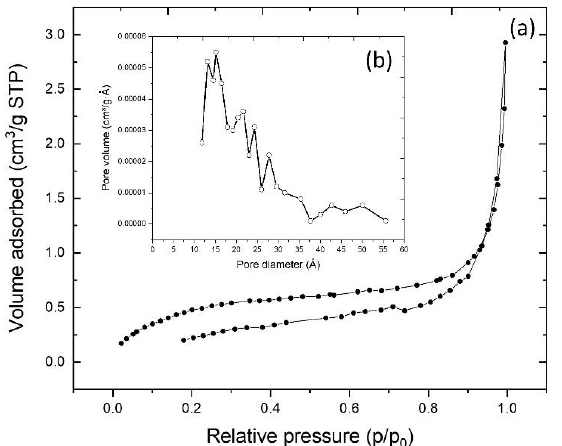
Figure 2. FTIR spectrum of the CRS sample obtained, indicating the assignment of the different peaks.